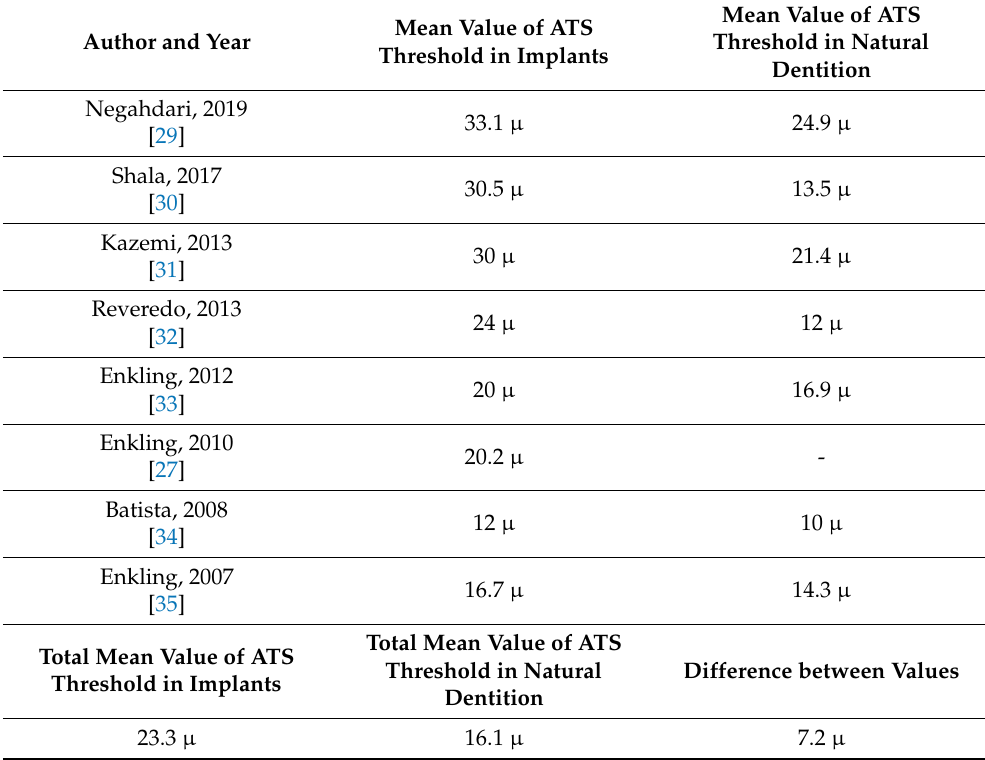
Table 3. ATS in implant prosthesis and natural dentition.